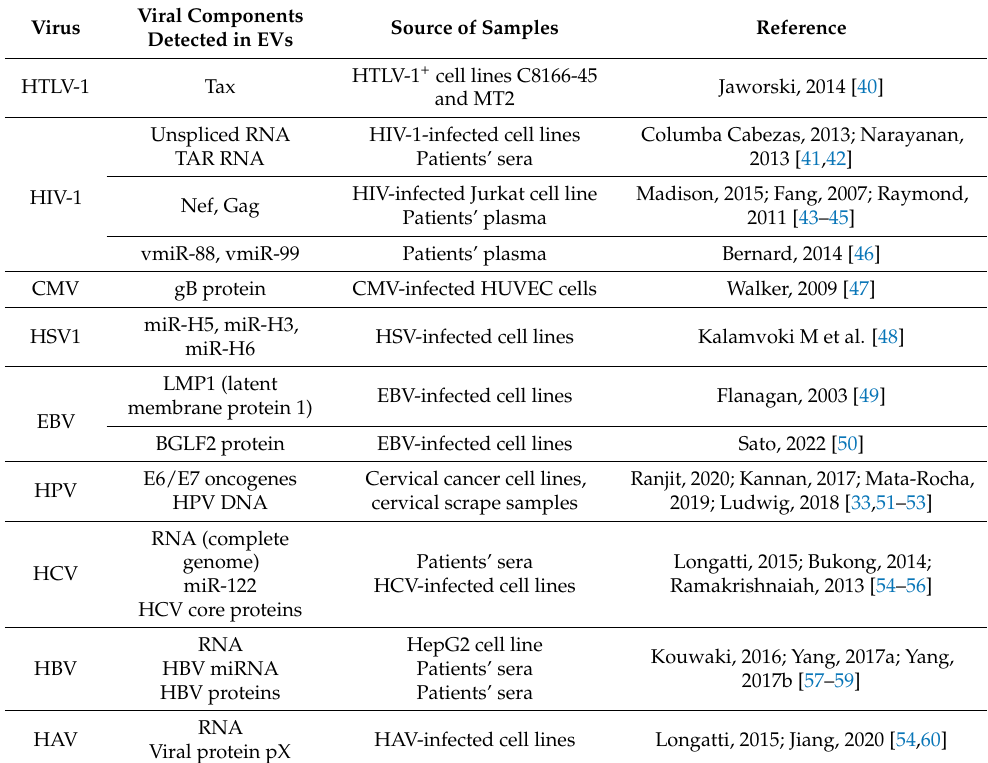
Table 1. Virus-derived components in extracellular